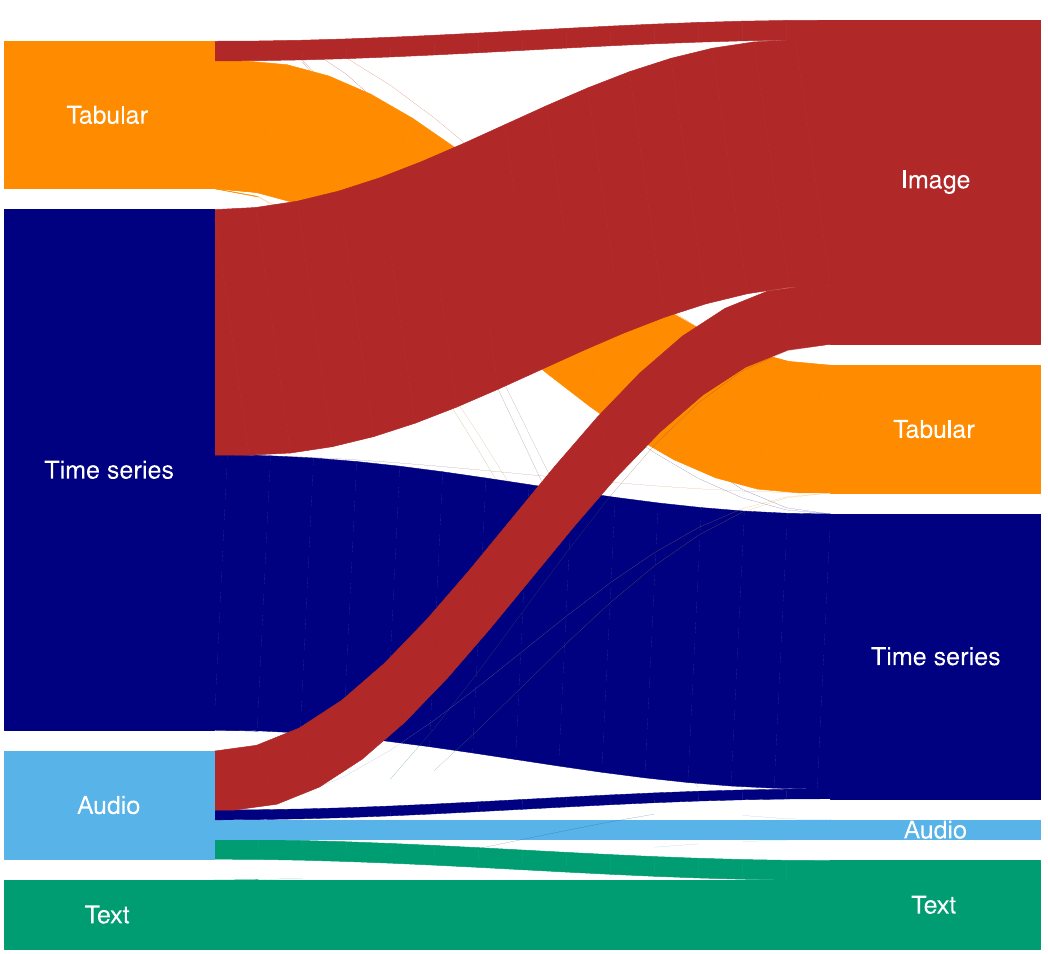
Fig 3. Visualization of data types (target) analyzed in the studies (on the left side) and the type of data that the reused model (source) was built on (on the right side).